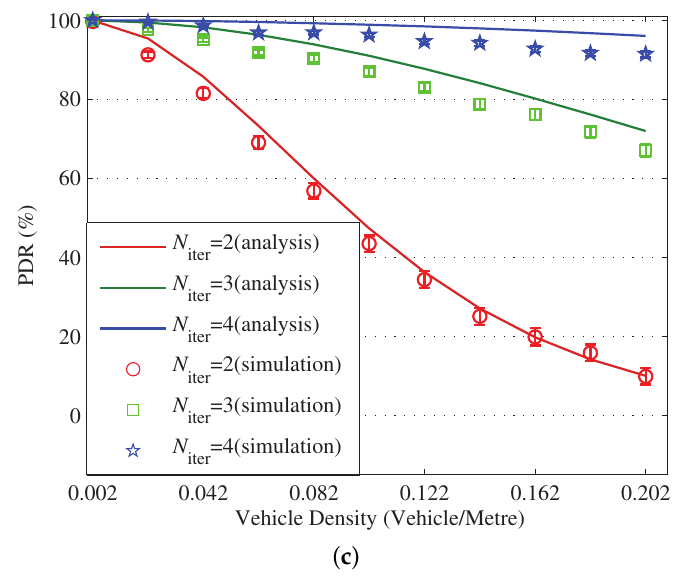
Figure 8. Validation of the analytical model for PDR. ( a ) When ( N iter , N part ) = ( 2,3 ) ; ( b ) When ( N iter , A ) = ( 2,0.1 ) ; ( c ) When ( N part , A ) = ( 3,0.1 )